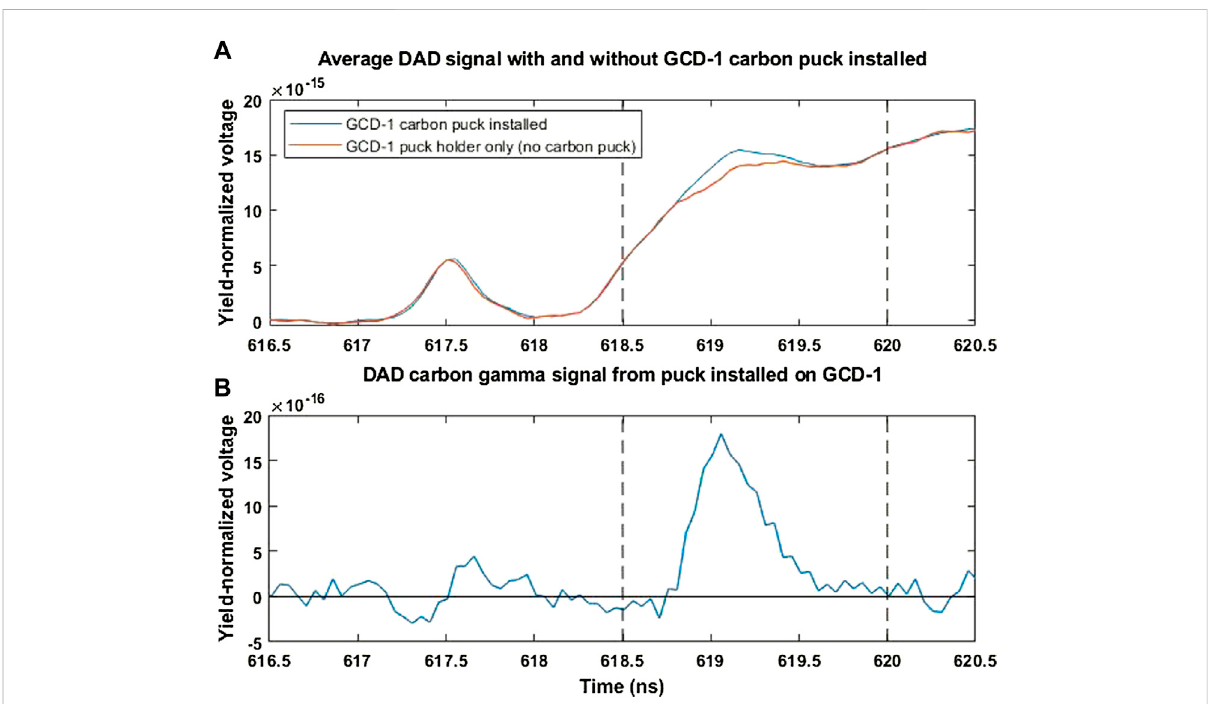
FIGURE 5 Average DAD calibration data with and without the carbon puck in place (A) and the carbon gamma data resulting from their subtraction (B) . Backgrounddatawithoutthecarbonpuck includedthepresenceofthealuminum puck holder.Theareaofthesubtractedsignalisusedtocalculate the carbon calibration constant χ . The dashed vertical lines in the plot represent the times over which the area was